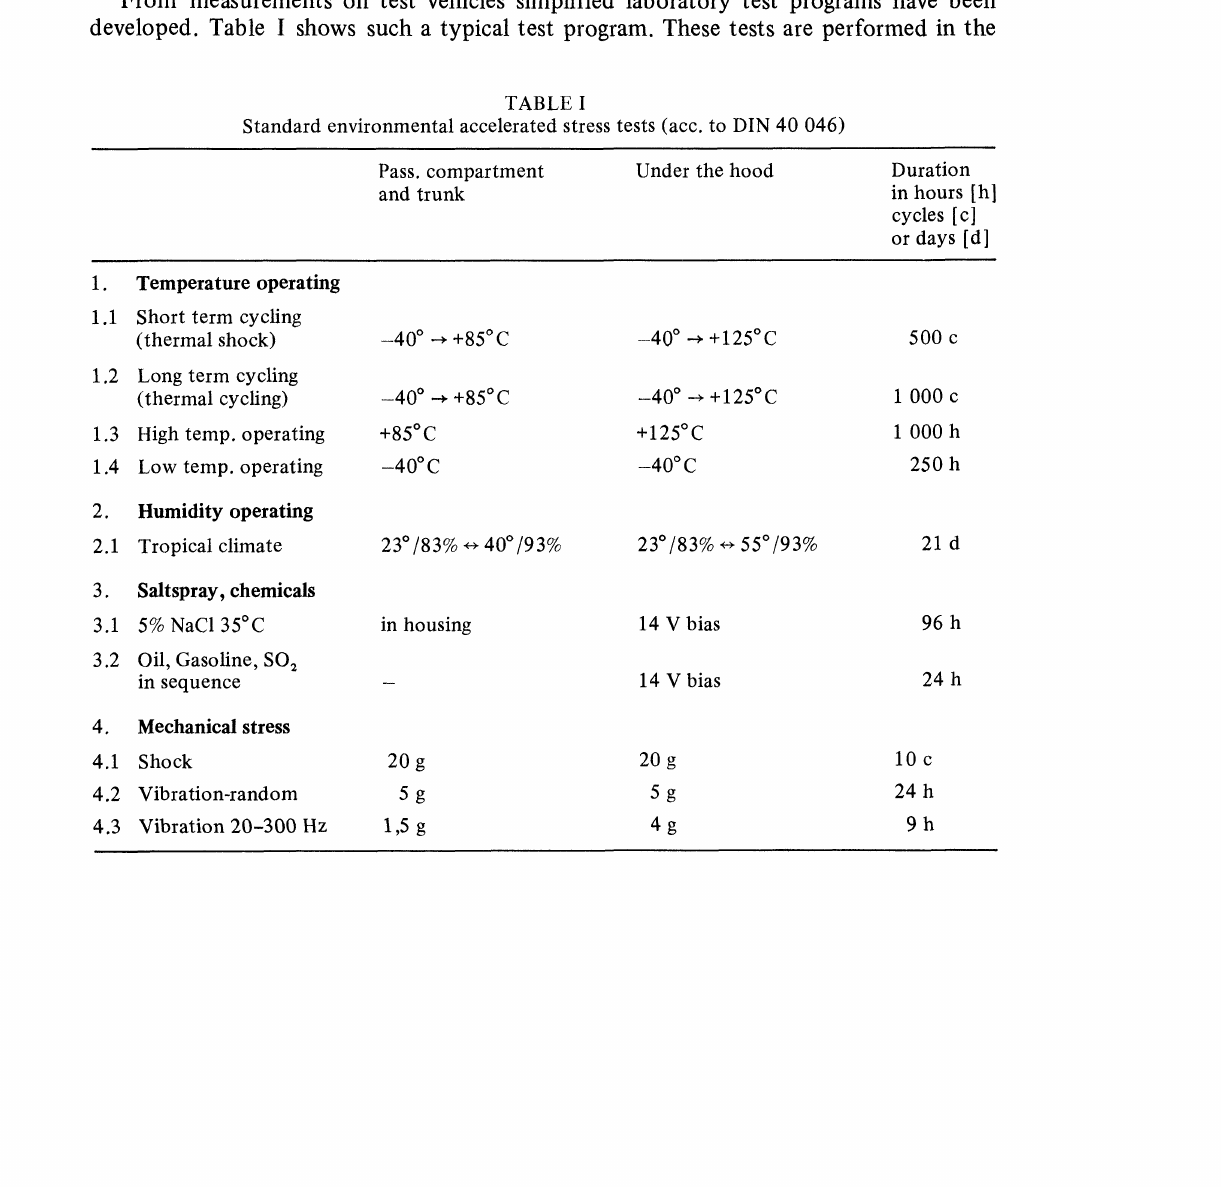
TABLE Standard environmental accelerated stress tests (acc. to DIN 40 046) Pass.